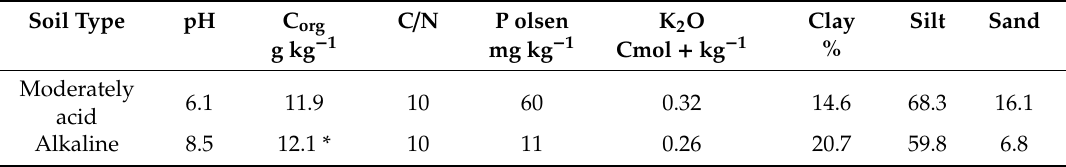
Table 1. Soil physical and chemical